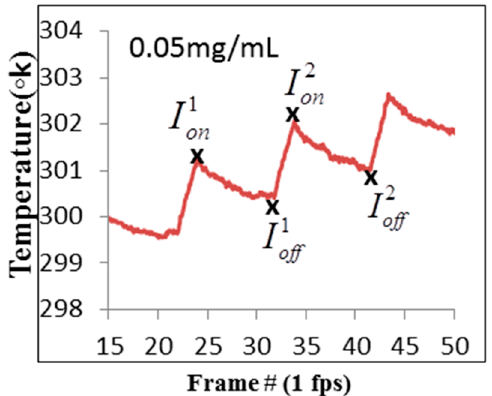
Figure 7. Temperature change as a function of frame number for GNR concentrations of 0.05 mg/mL and 20% duty-cycle laser illumination. The specific frames that were used in the proposed method are marked with a black x .